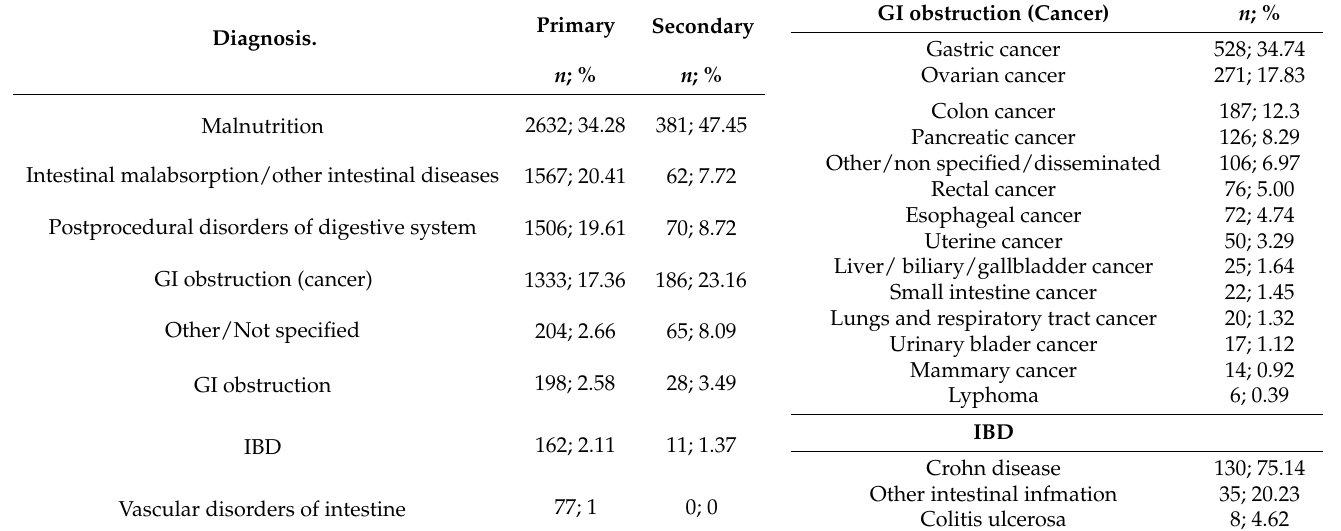
Table 1. Main and secondary